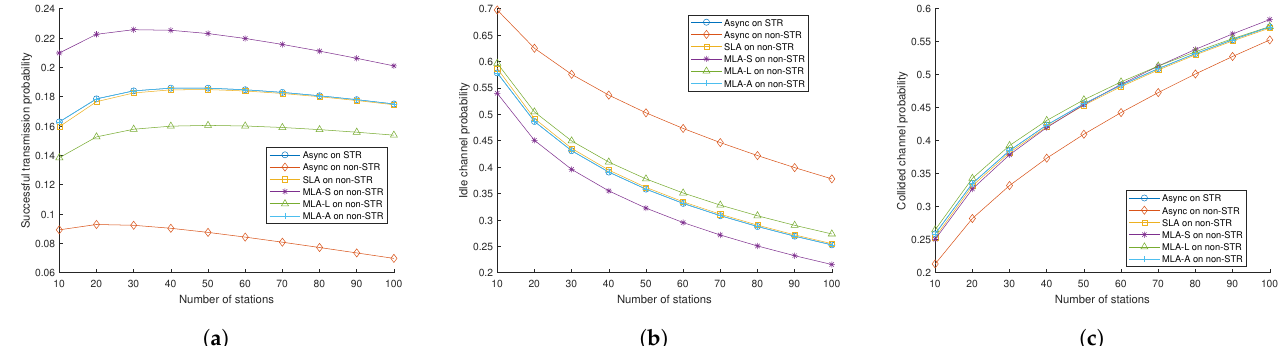
Figure 13. ( a ) Successful transmission probability, ( b ) idle channel probability, and ( c ) collided transmission